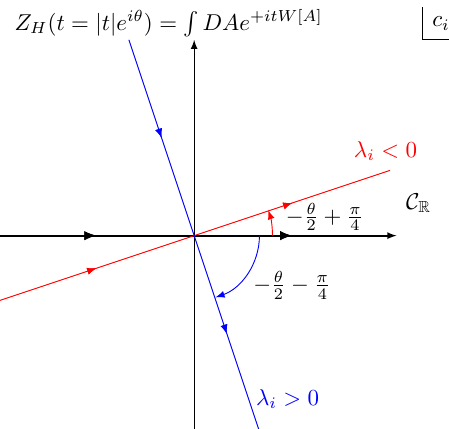
Figure 3 . Deformation of Steepest Descent Paths of Z